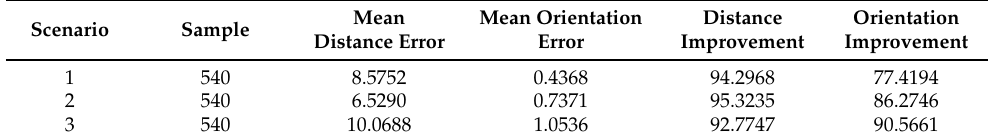
Table 3. Effect of angle on improving the position and orientation of the